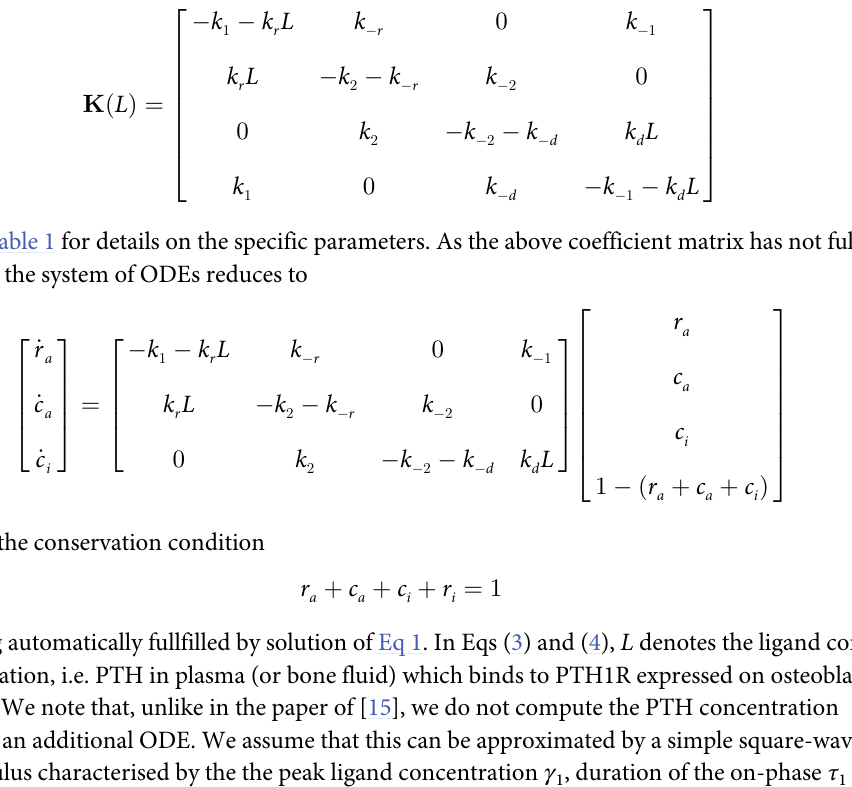
Table 1. Parameter values for the two-state receptor model of PTH-PTH1R as illustrated in Fig 1. Parameter Rate constant description Value Source k 1 conversion receptors: R a ! R i 0.012 min − 1 [31] k − 1 conversion receptors: R i ! R a 0.104 min − 1 k 2 conversion complexes: C a ! C i 0.222 min − 1 k − 2 conversion complexes: C i ! C a 0.055 min − 1